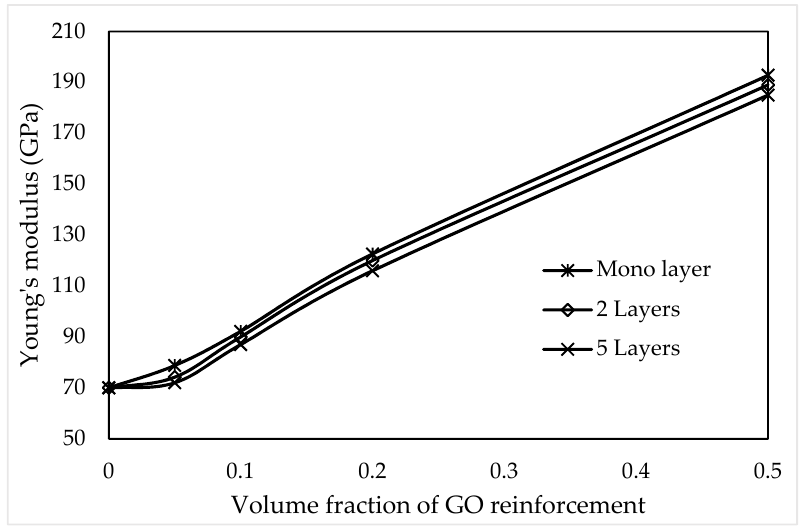
Figure 8. Young’s modulus of GO/Al composites at different numbers of GO layers.